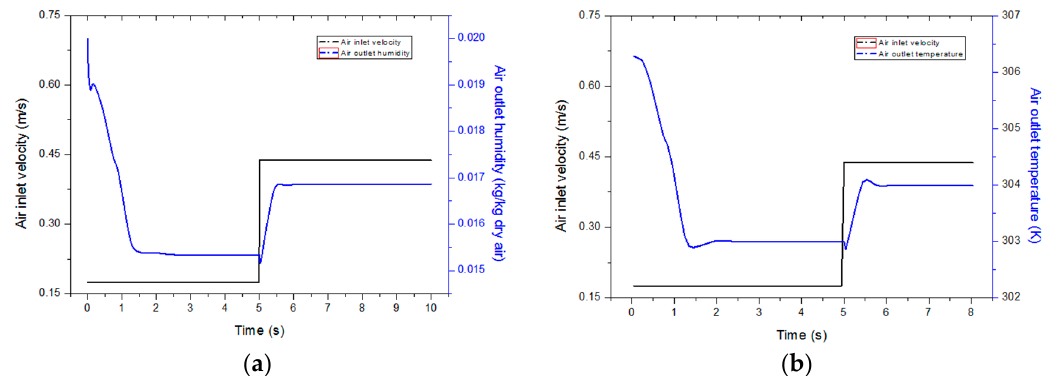
Figure 3. Humidity and temperature variation under step change of air velocity. ( a ) air outlet humidity; ( b ) air outlet temperature.